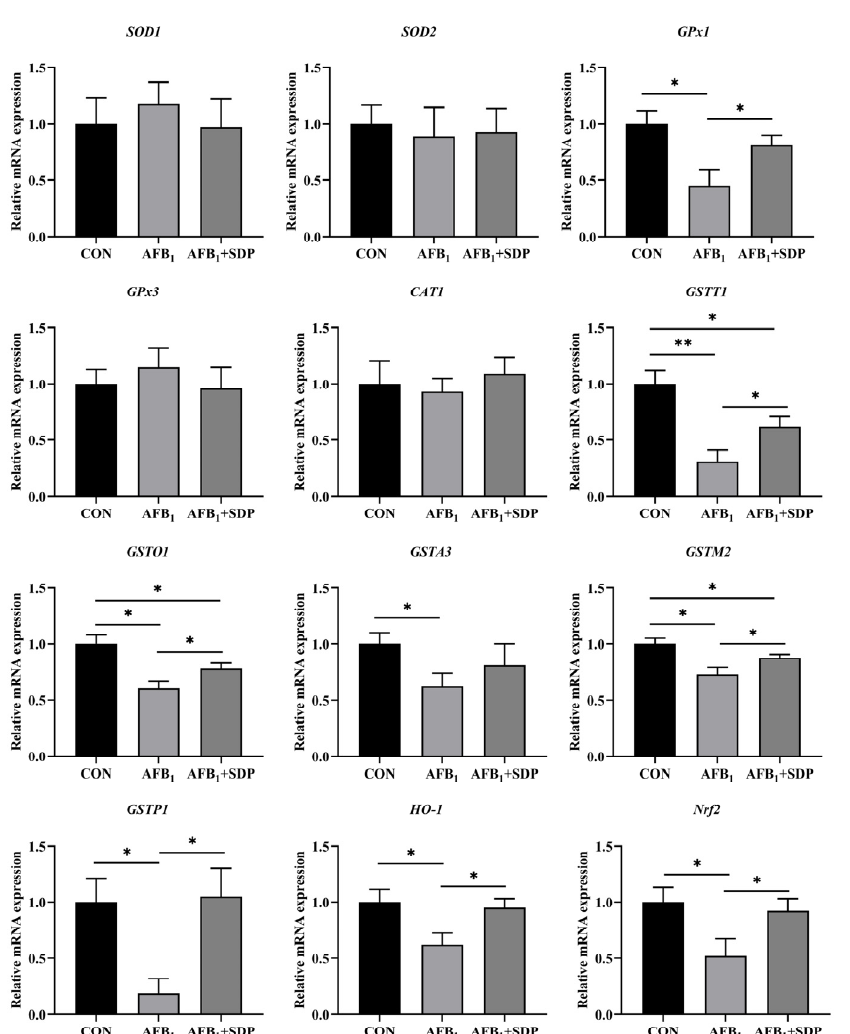
Figure 5. The protective effects of dietary seaweed ( Enteromorpha prolifera )-derived polysaccharides on hepatic mRNA expression of antioxidant phase II detoxification enzyme-related genes in broiler chickens. * p < 0.05, ** p < 0.01, no superscript marks indicated that p > 0.10. CON: control group; AFB 1 group: (fed diet with 0.1 mg/kg AFB 1 ); AFB 1 + SDP group (AFB 1 group + 0.25% SDP).